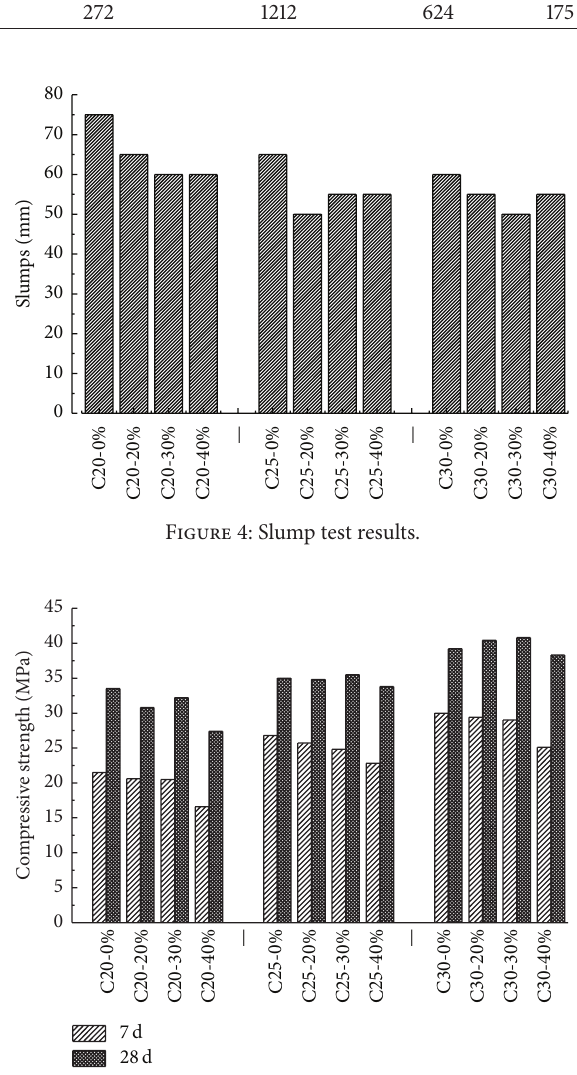
Figure 5: Compressive strength test